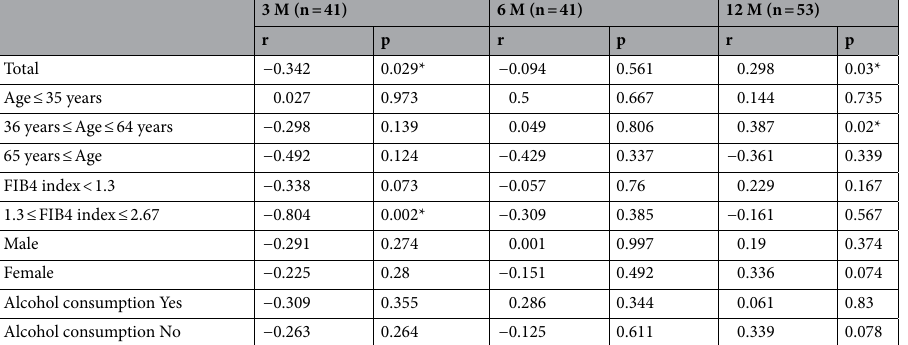
Table 4. Correlations between the amount of weight lost and changes in the FIB4 index. Patients successfully reduced their BW by more than 5% from baseline BW after 3, 6, and 12 months (M) of weight reduction therapy. Alcohol consumption was defined as current alcohol habits via a self-report and physician’s interview. Yes: almost every day or sometimes. No: never. Asterisks indicate a significant difference (p <